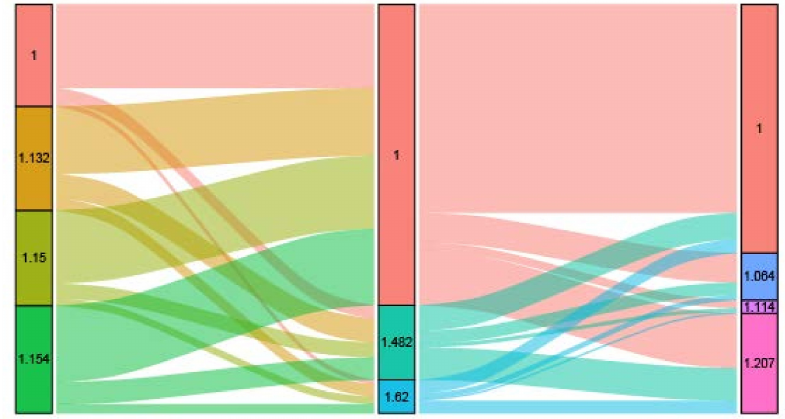
Figure 3. Graphical summary of the distribution and associations of different score subgroups in county-level median household income, insurance status and marital status, respectively.